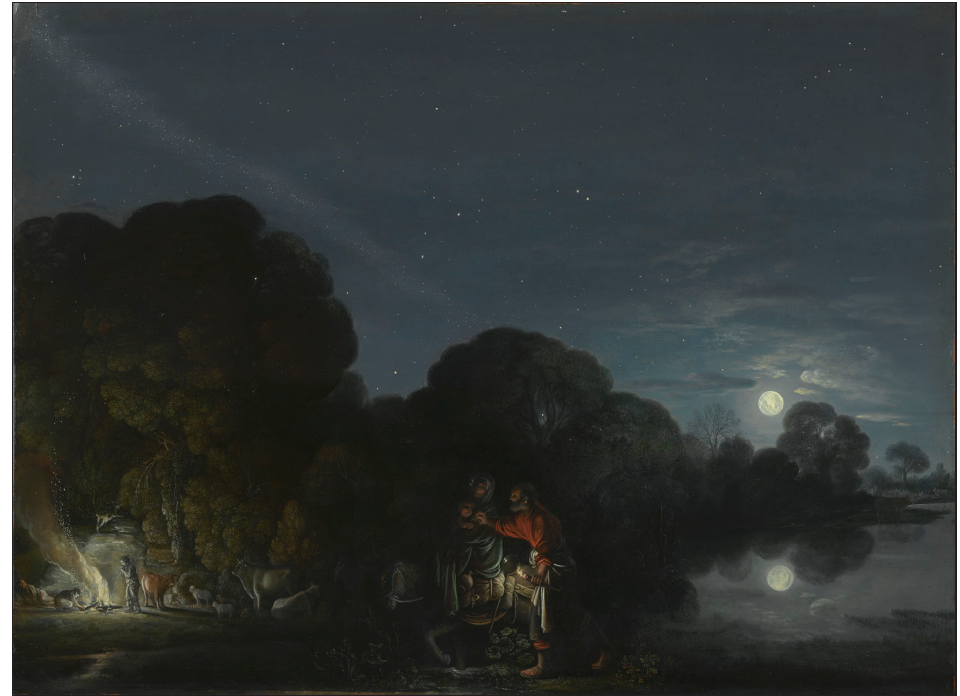
Figure 1: Adam Elsheimer, The Flight into Egypt , 1609, oil on copper, 31 × 41 cm. © Alte Pinakothek,